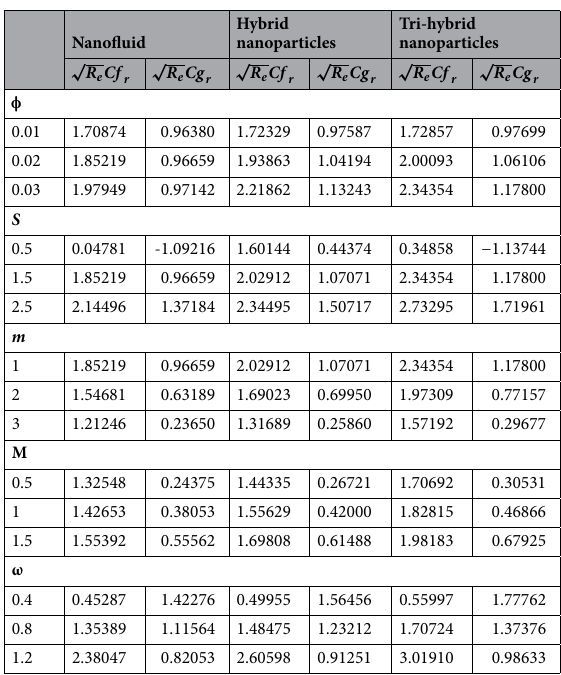
Table 3. Skin friction model that compares NF, HNFs, and tri-HNFs.